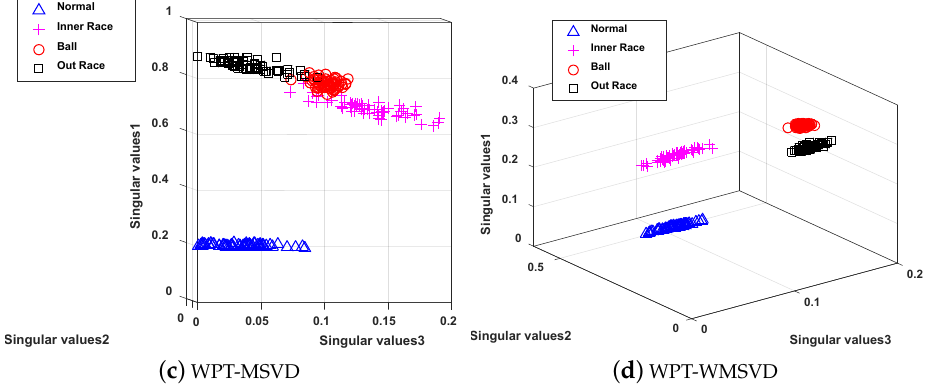
Figure 17. The Visualization of feature extraction effect of four methods under minor faults: ( a ) Dis- tribution of the data samples based on WPT-PCA; ( b ) Distribution of the data samples based on WPT-SVD; ( c ) Distribution of the data samples based on WPT-WSVD; and, ( d ) Distribution of the data samples based on WPT-MWSVD.